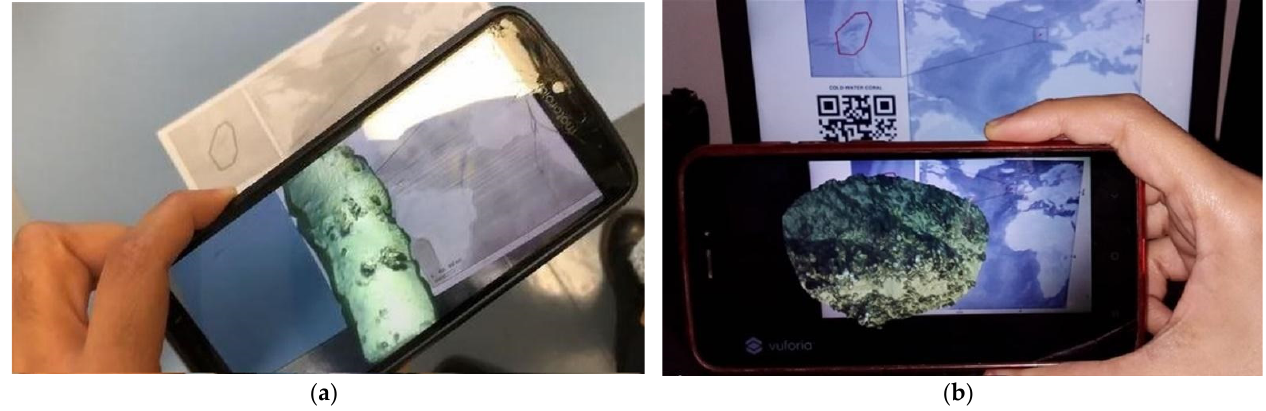
Figure 4. Demonstration of AR APP integration with the mobile phone and QR Code of two models. The background image shows the map of the study area in relation to Ireland and the QR Code for interaction: ( a ) demonstration of APP visualisation of Model D and ( b ) demonstration of APP visualisation of Model B.